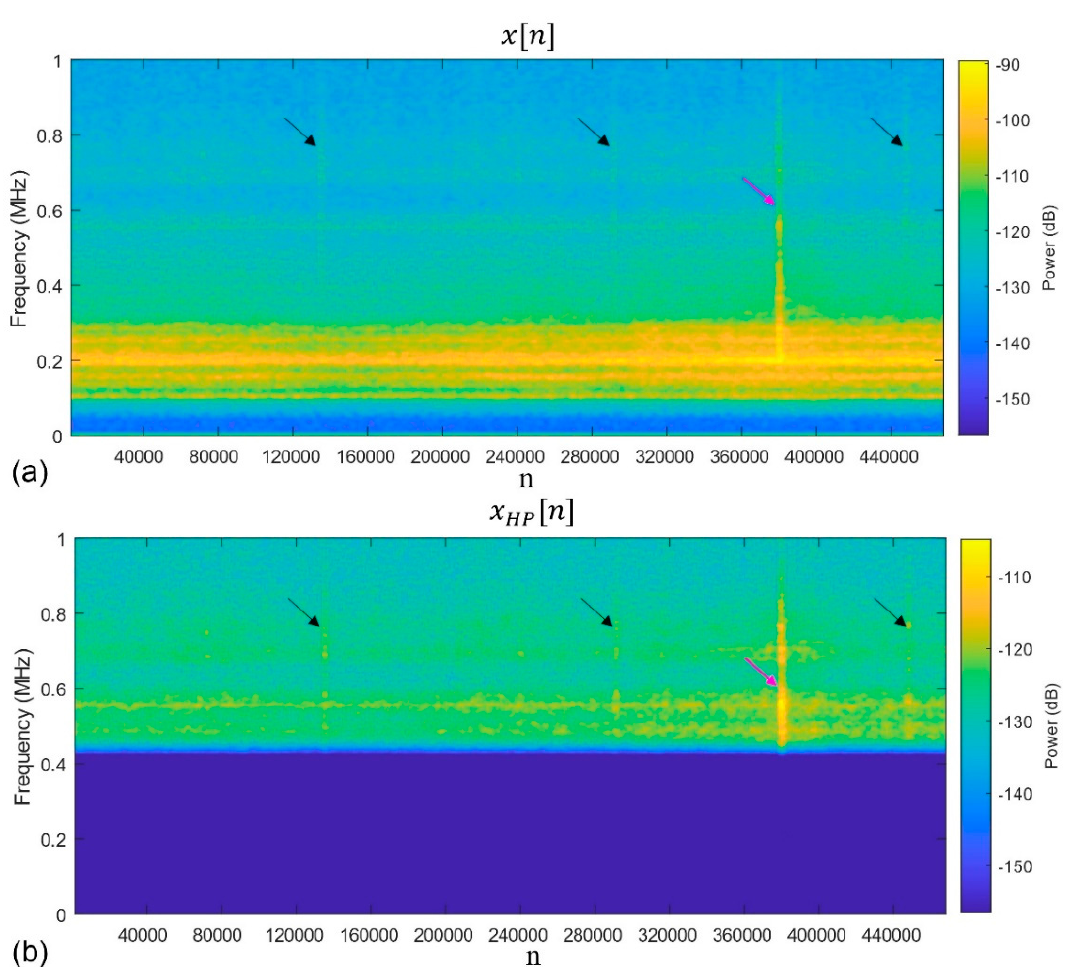
Figure 4. The spectrogram for ( a ) x [ n ] and ( b ) x HP [ n ] , illustrating the noise filtering procedure (compare ( a , b ) with and without the low-frequency components in the spectrograms, respectively). The black arrows indicate the AE pulses repeating at f fault = 3/ rev , and the pink arrows indicate the AE pulses repeating at f fault = 1/ rev